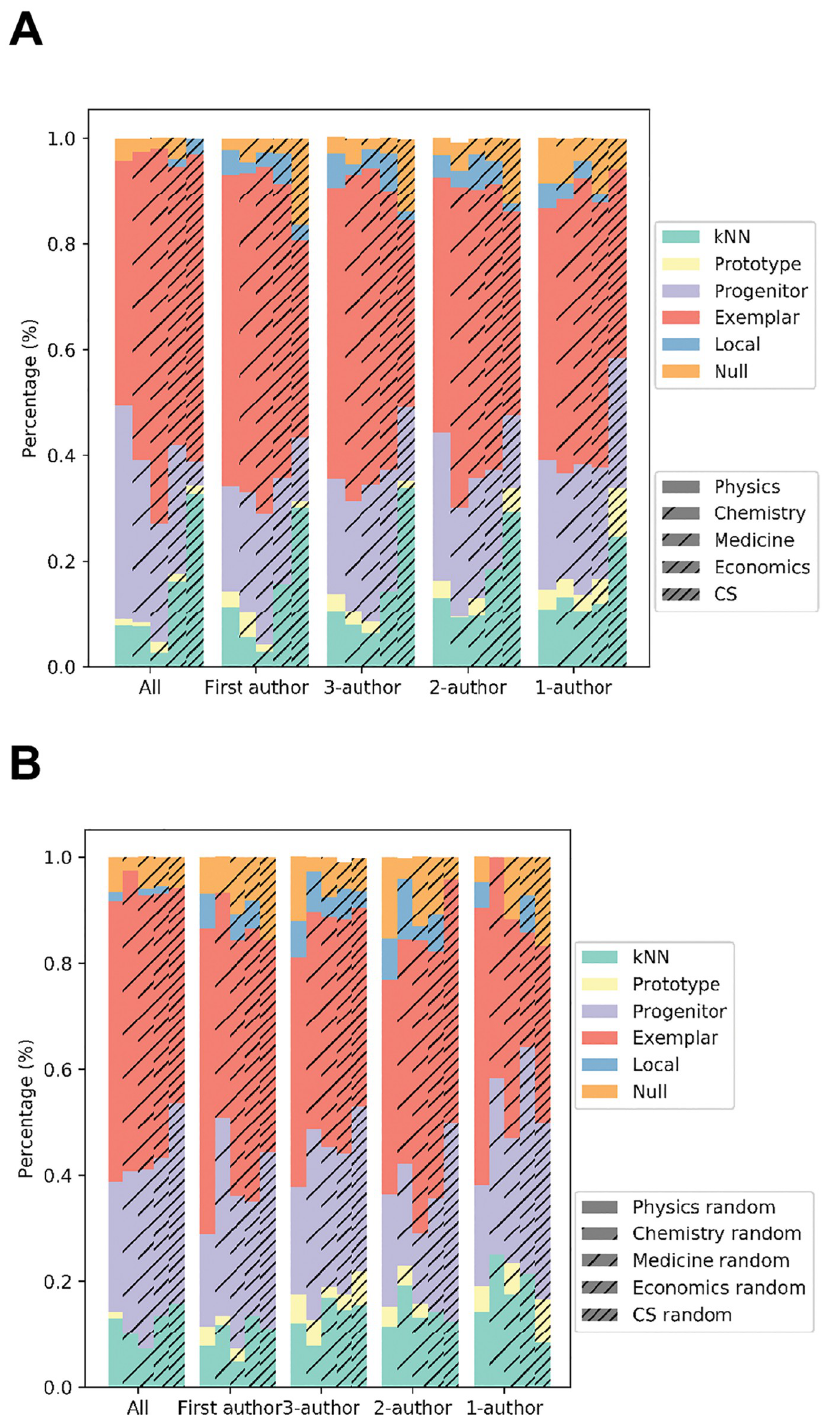
Fig 3. Summary of results from the winner-take-all analysis. (A) Bar chart indicates the winning percentage of a model in predicting the historical emergence of publications from the prominent (or award-winning) scientists across the 5 fields (“CS” stands for computer science). Different groups of bar charts display winning percentages under different authorship conditions. (B) Similar information for the random-sampled scientists.